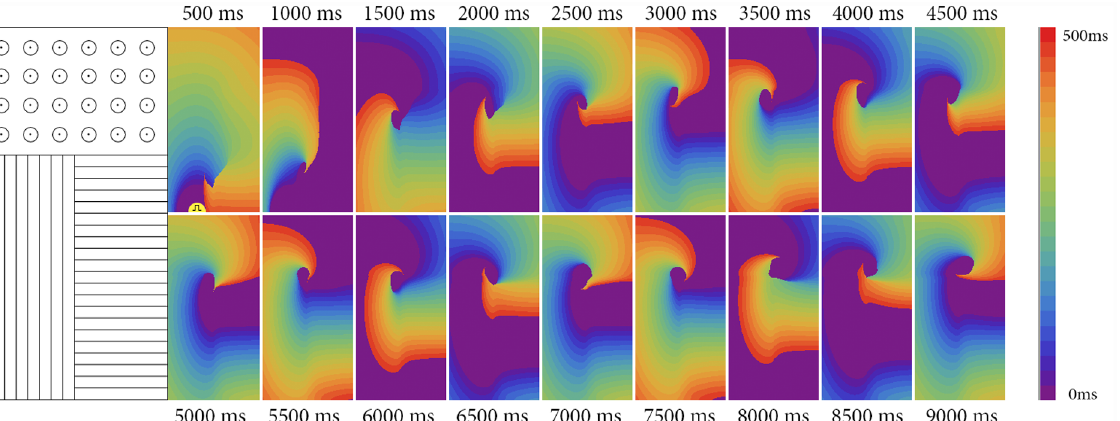
Fig 10. Reentry formation at the border between areas with orthogonal fiber orientation, stabilized at the isotropic area. Two point stimuli were applied 6 mm from the border with a delay of 500 ms. The AR is 2.0 and [ K + ] o is 10 mM. Fiber alignment is shown in the left figure. Size of the tissue: 6.4 cm x 3.2